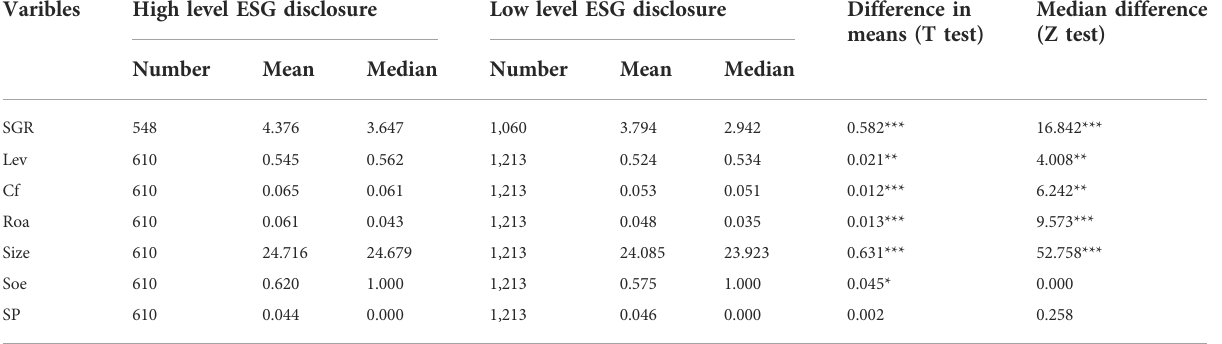
TABLE 3 Statistics of the regression